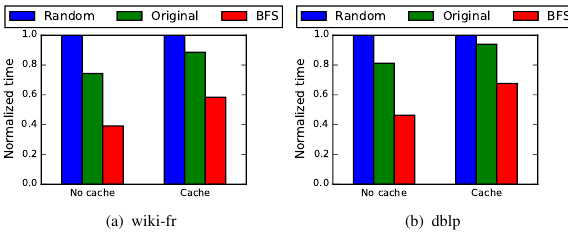
Fig. 11 Impact of vertex layout on 2-hop neighborhood queries. Fig. 12 Multithreaded 2-hop neighborhood